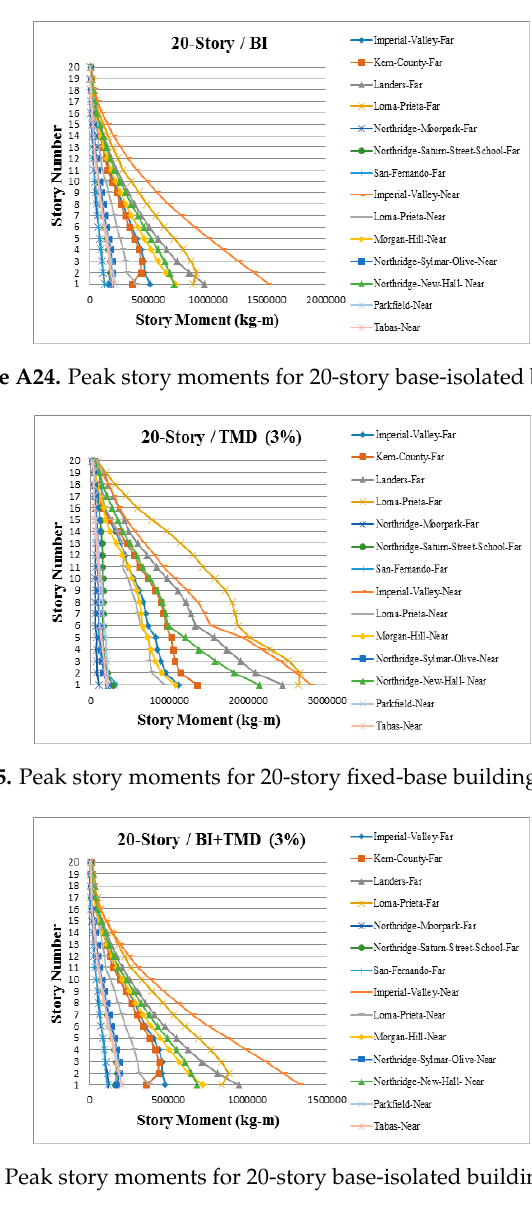
Figure A23. Peak story moments for 20-story fixed-base building.